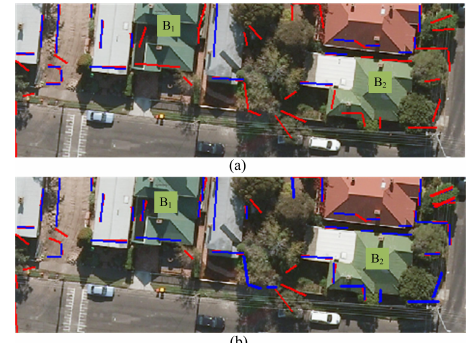
Figure 3: Detection of green buildings: (a) the NDVI informa- tion alone missed green buildings whereas (b) combined NDVI and entropy information detects green buildings. ‘Blue’ lines are accepted, ‘red’ represents